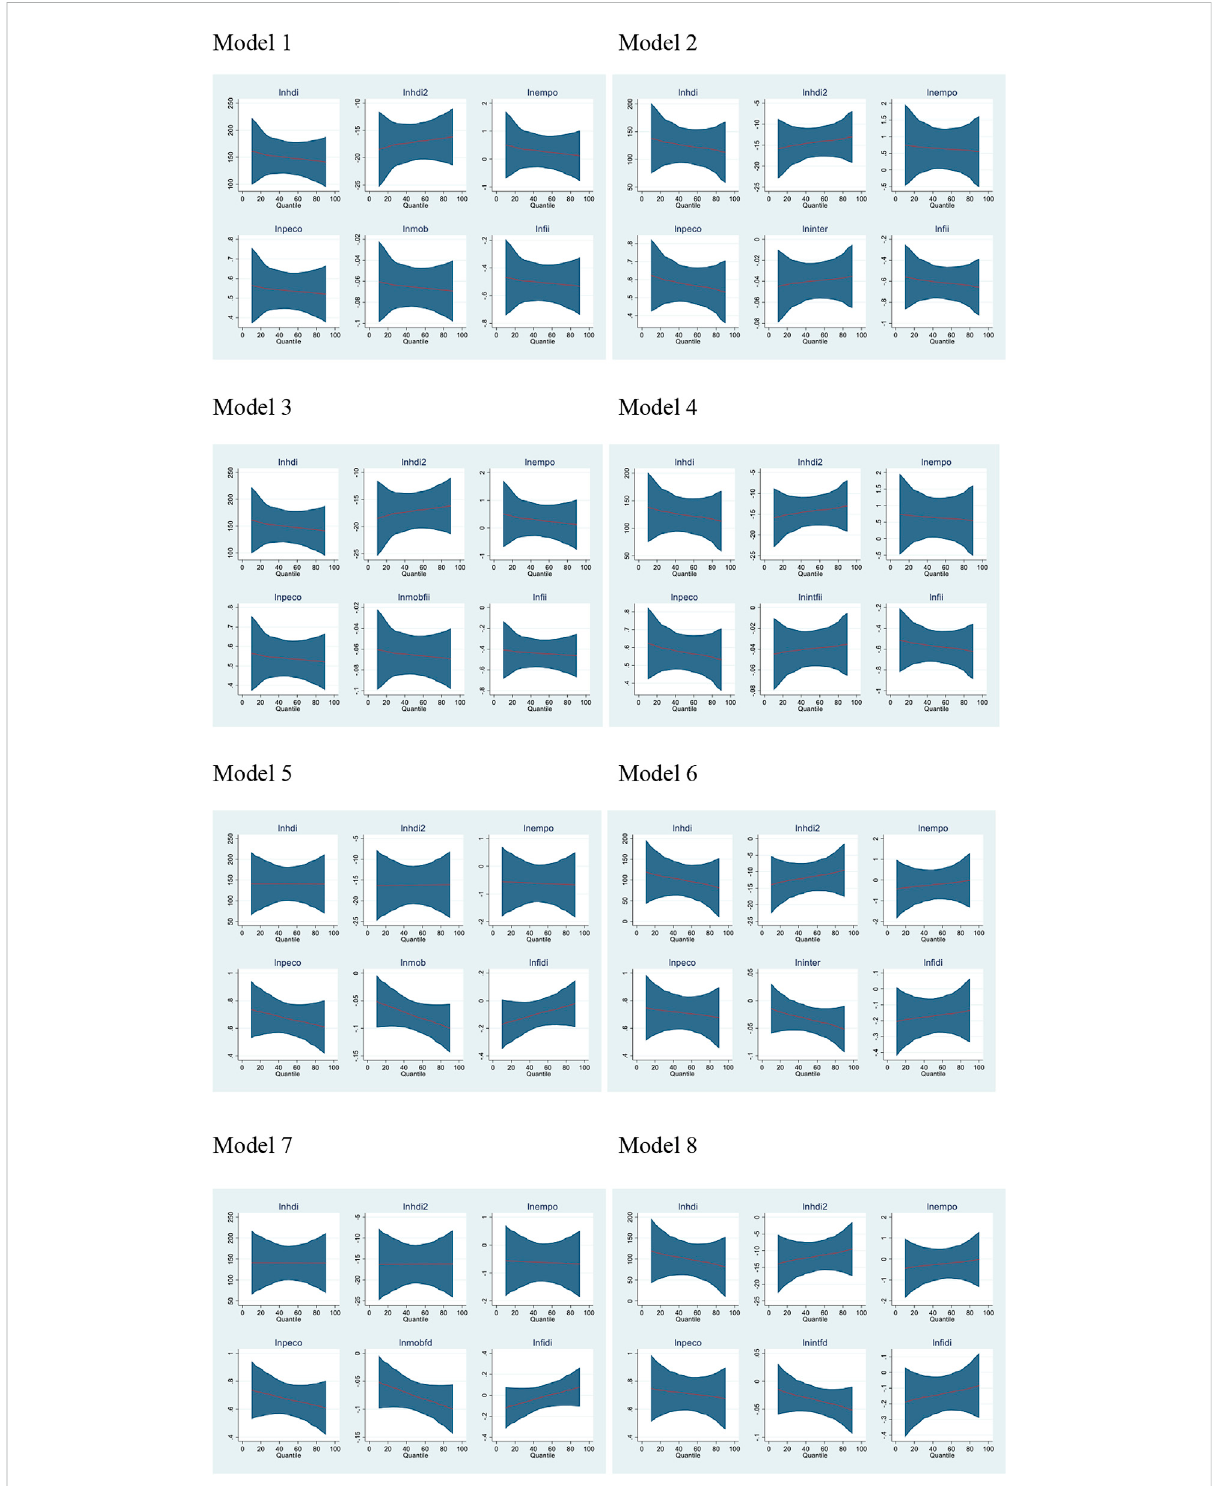
FIGURE 1 Plotting results from panel quantile regression. Note: lnhdi = LHDI, lnhdi2 = LHDI2, lnempo = LEMPO, lnpeco = LPECN, lnmob = LMPH, lninter = LIUI, ln fi i = LINFII, ln fi di = LINFID, lnmob fi i = LMod1, lnint fi i = LMod2, lnmobfd = LMod3, lnintfd =